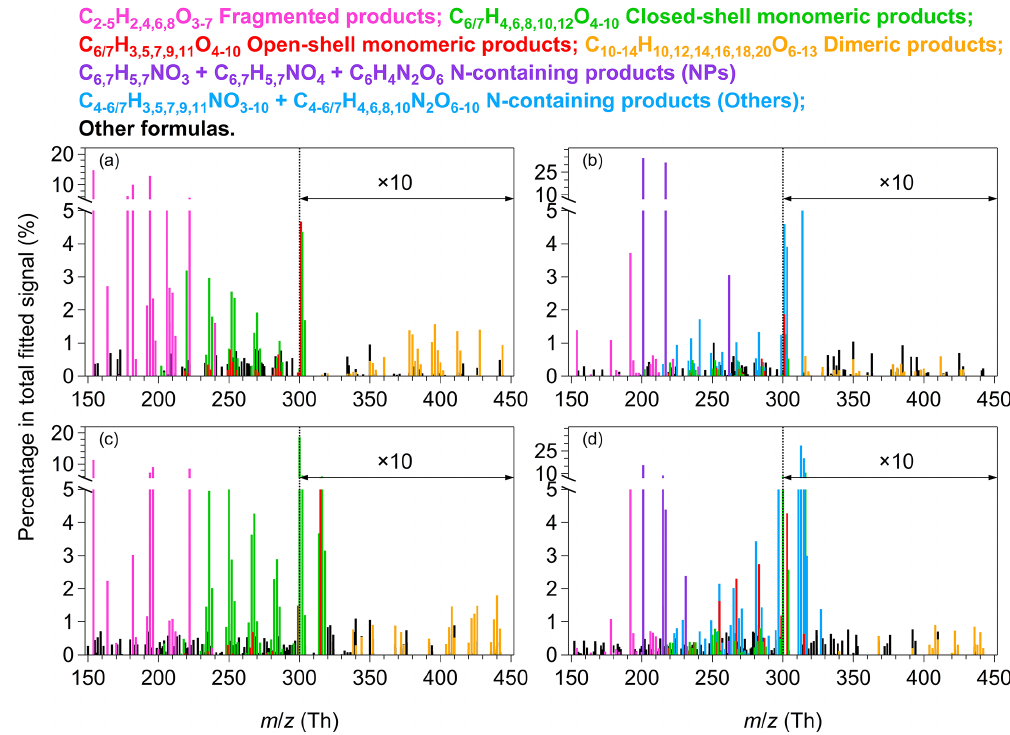
Figure 1. Mass spectra of HOM products measured by the NO − and OFR254-5. (b) Benzene and OFR254-5–iN 2 O4.4. (c) Toluene and OFR254-5. (d) Toluene and OFR254-5–iN 2 O4.4. The reagent ion NO − is omitted from the molecular formulas, whereas the m/z values refer to the mass-to-charge ratios of the fitted ions, with NO − 3 relative intensities of ions having m/z ≥ 300 are multiplied by